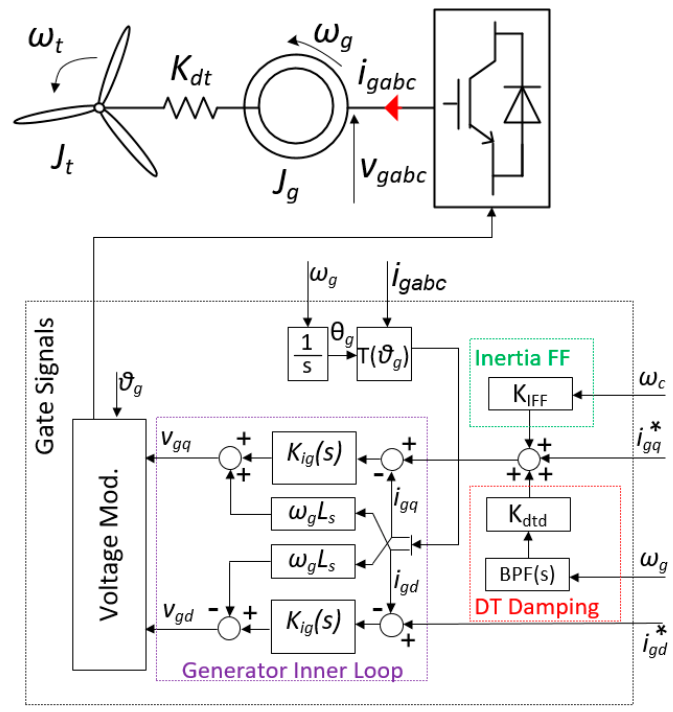
Figure 2. Generator controller structure. DT: Drivetrain, FF: Feedforward.